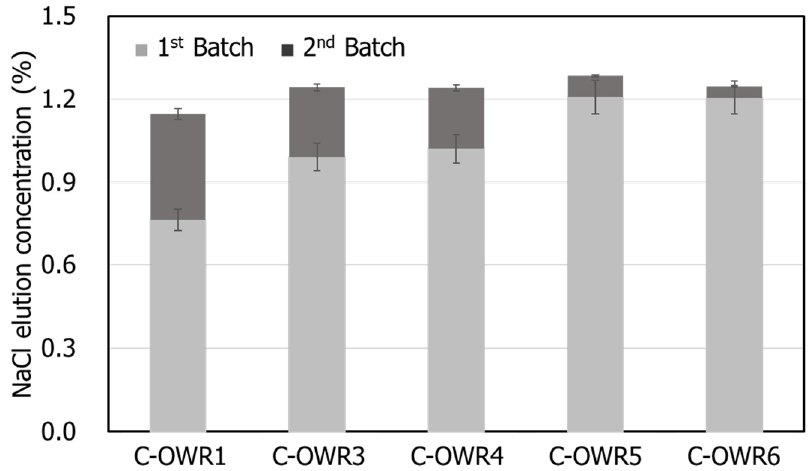
Figure 4. NaCl elution concentration via first and second batch system with various